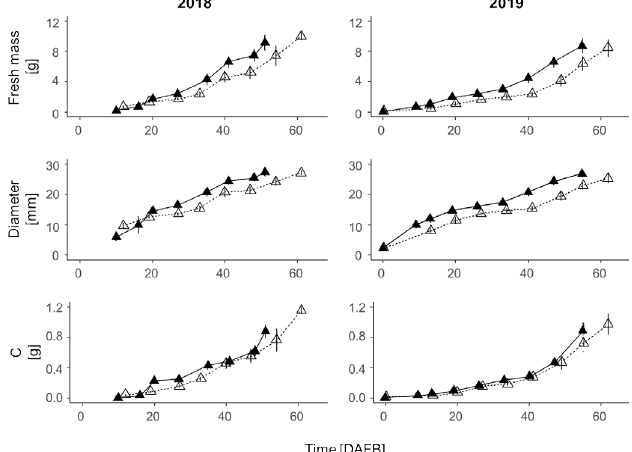
Fig. 1: Time course fresh mass, diameter and carbon content of developing 'Bellise' (closed symbol, solid line) and 'Regina' (open symbol, dot- ted line) sweet cherry fruit during two growing seasons. Error bars show the standard